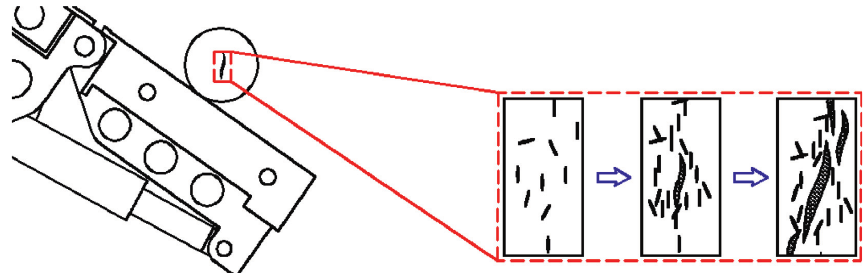
Figure 6: Fracture process of coal gangue